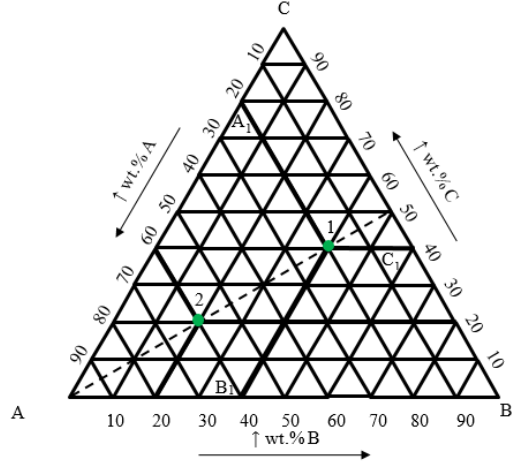
Figure 4. Ternary phase diagram A–B–C.